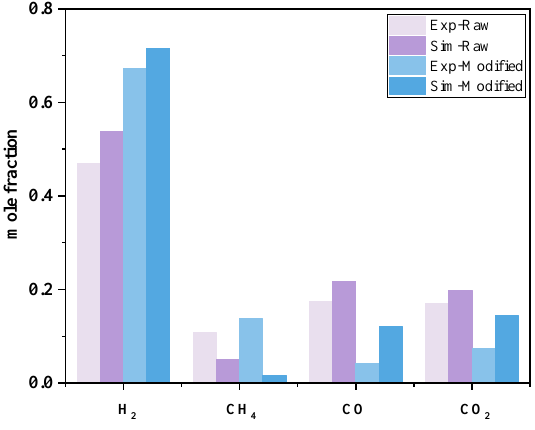
Figure 13. Simulation result for basic scenario.